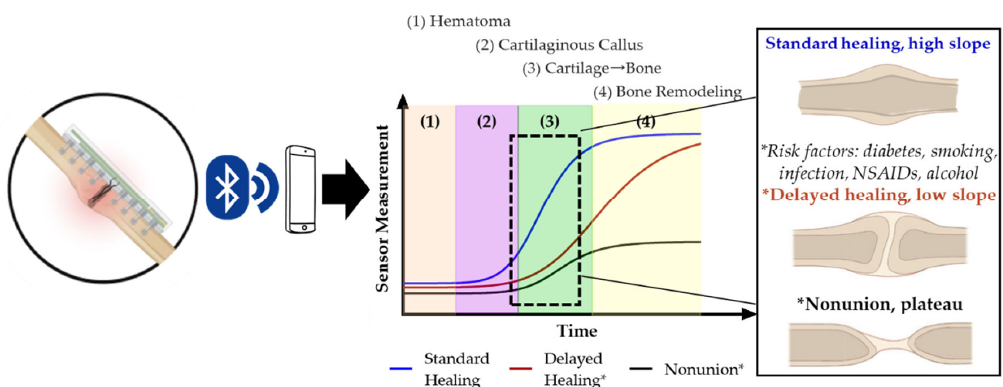
Figure 8. Pictorial representation of theoretical standard, delayed, and nonunion healing curves [9].